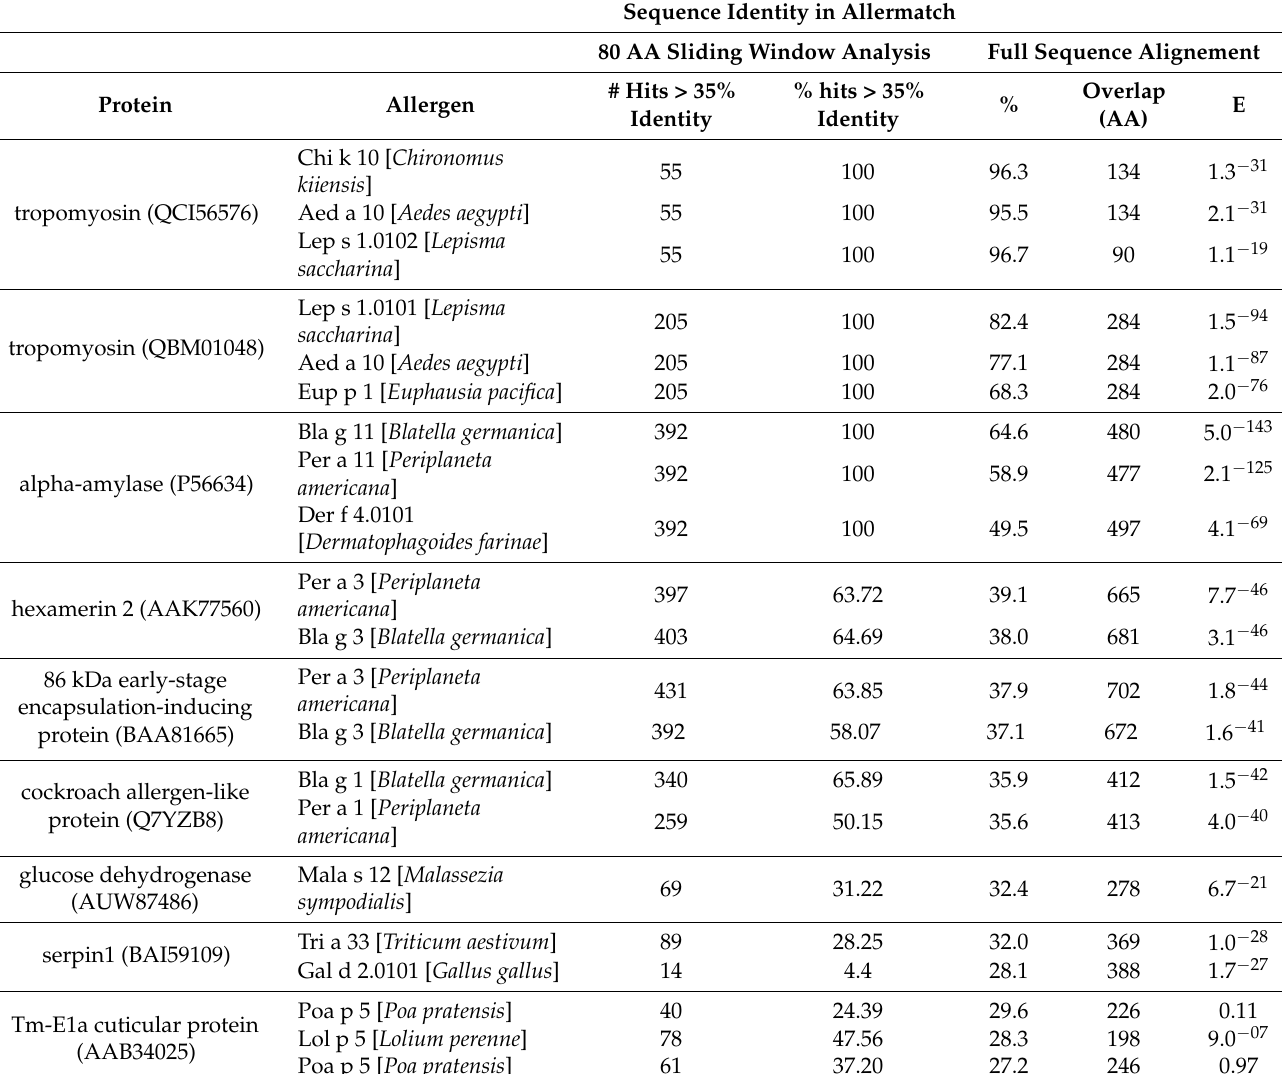
Table 4. Identified allergenic proteins of the yellow mealworm according to Allermatch TM . For the proteins with the large number of matches, only the three best matches found are